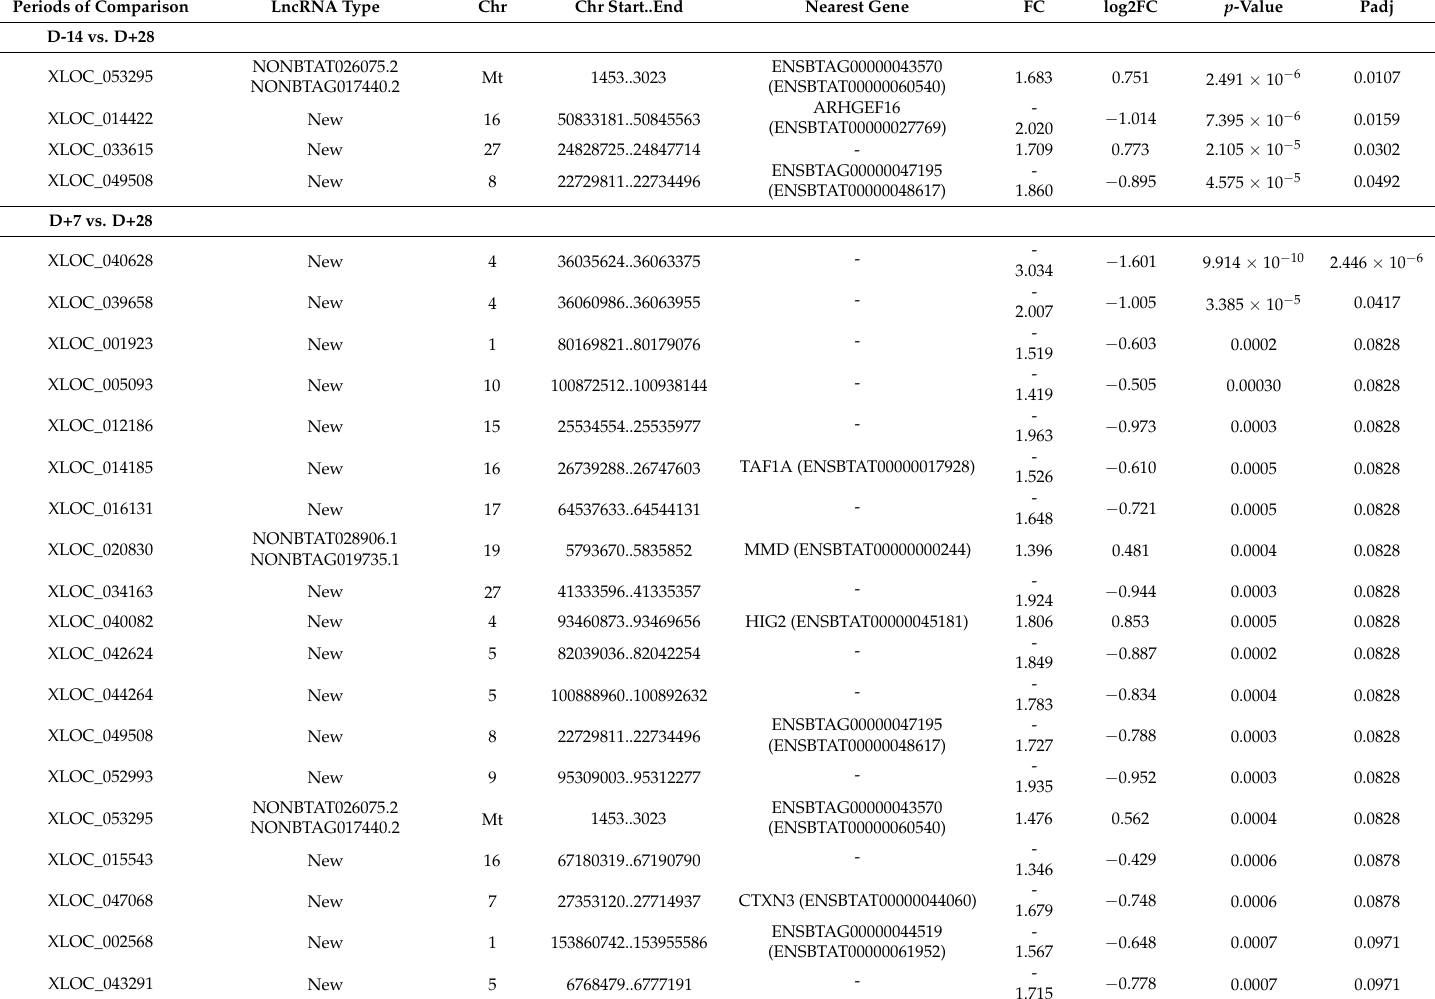
Table 4. Differentially expressed lncRNAs in response to dietary supplementation with 5% safflower